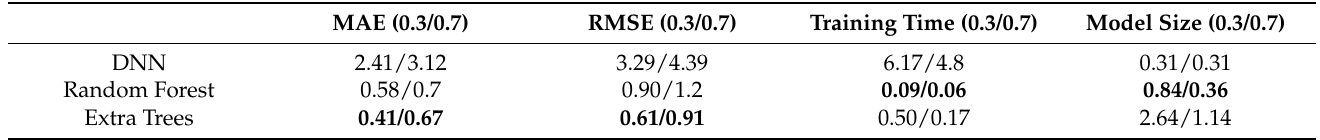
Table 5. Transfer learning results at different test sizes (0.3 and 0.7 of the subject’s